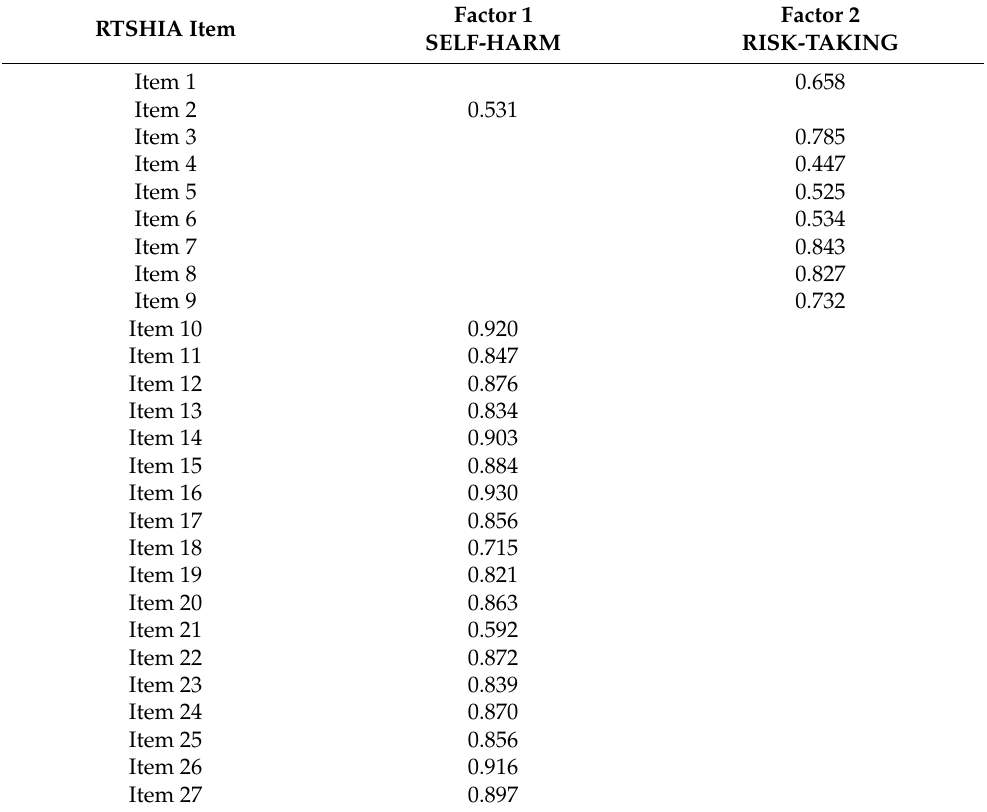
Table 1. Component Loadings for 27 items